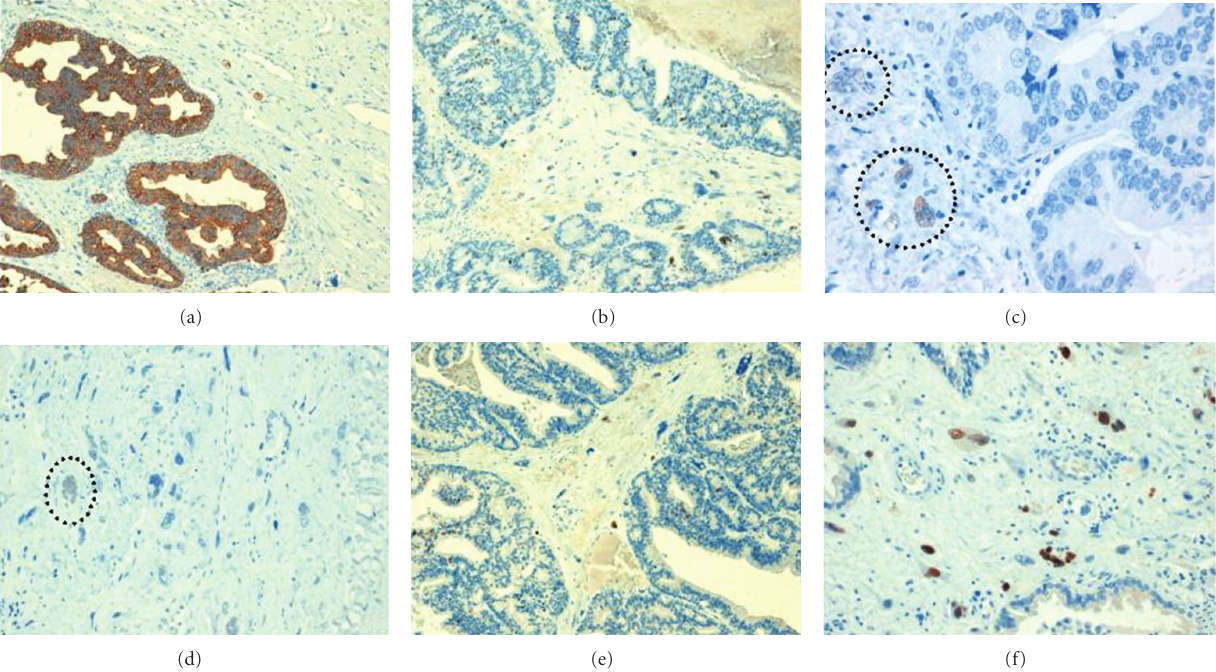
Figure 3: Immunohistochemical profile. (a) Cytokeratin AE1/ae3 stain showing a strong reactivity in epithelial component and focal expression is present at mesenchymal component (DAB, 100x). (b) Ki-67 nuclear positivity in both epithelial and mesenchymal component (DAB, 100x). (c and d) Estrogen and progesterone receptor expression. Multinucleated stromal cells showing nuclear positivity (Circle) (DAB, 400x). (e and f) p63 immunoreactivity in epithelial and stromal elements (DAB,